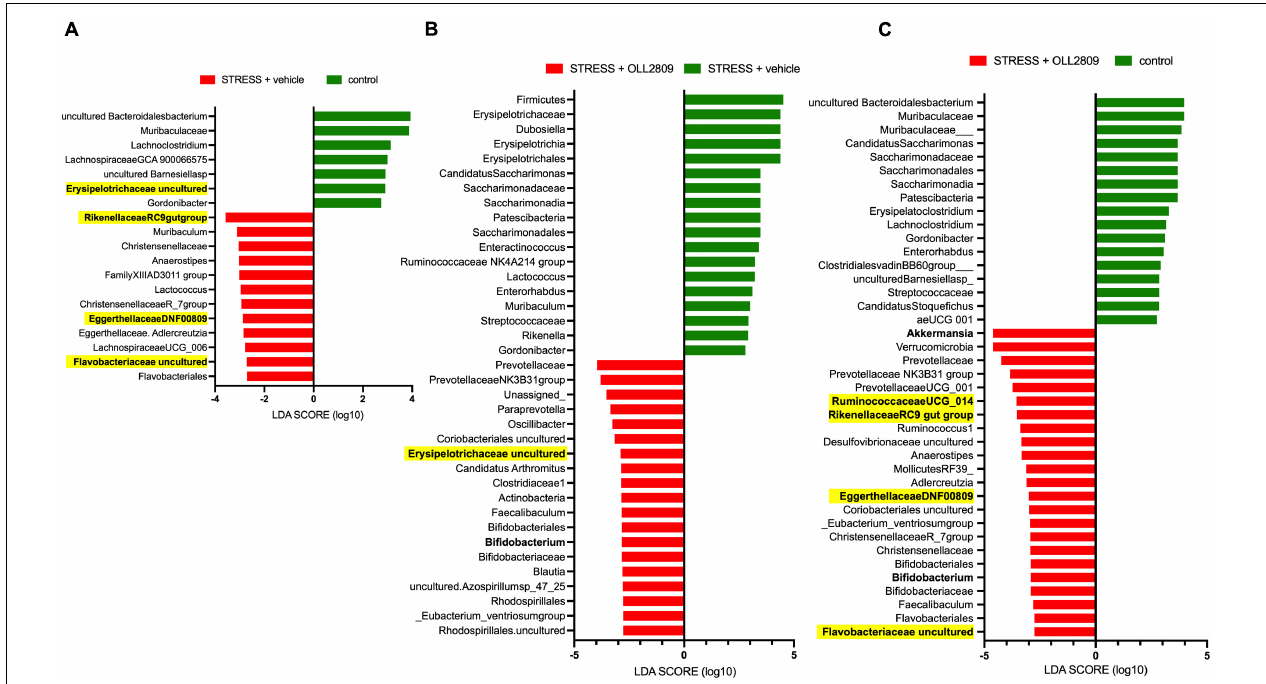
FIGURE 4 | Taxonomic differences in gut microbiota among control, stress + vehicle and stress + OLL2809 groups using linear discriminant analysis (LDA) effect size (LEfSe) analysis (LDA score > 2). (A) Control-enriched taxa are indicated with a positive LDA score (green), and taxa enriched by stress have a negative score (red). (B) Stress-enriched taxa are indicated with a positive LDA score (green), and taxa enriched in stress + OLL2809 mice have a negative score (red). (C) Control-enriched taxa are indicated with a positive LDA score (green), and taxa enriched in stress + OLL2809 mice have a negative score (red). Bacteria highlighted in yellow are correlated significantly with immobility time in the forced swim test. Control, n = 7; stress + vehicle, n = 5; stress + OLL2809, n = 5.